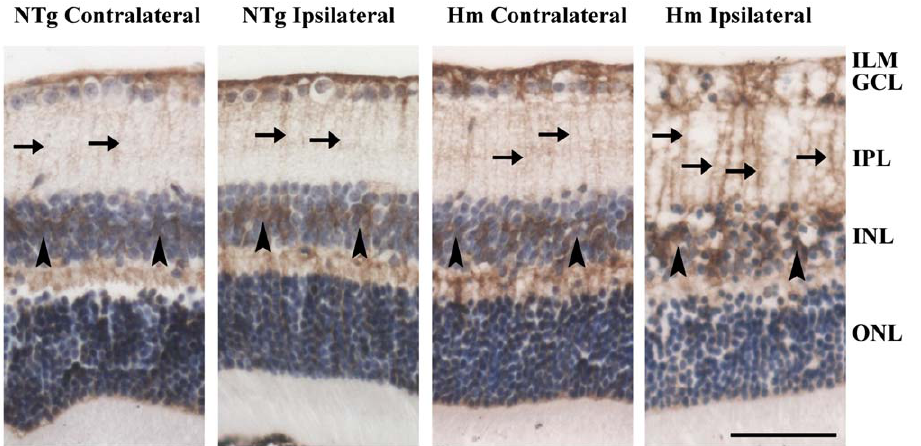
Figure 4. Immunohistochemical staining of glutamine synthetase (GS) antibody. Up-regulation of GS signal was found in the Mu¨ller cell processes in IPL (arrows) and Mu¨ller cell bodies in INL (arrowheads) in the ipsilateral retina of Hm TET-1 mice compared with the contralateral retina of Hm TET-1 mice and the ipsilateral retina of NTg mice. n=5 for each experimental group. Scale bar=50 m m.